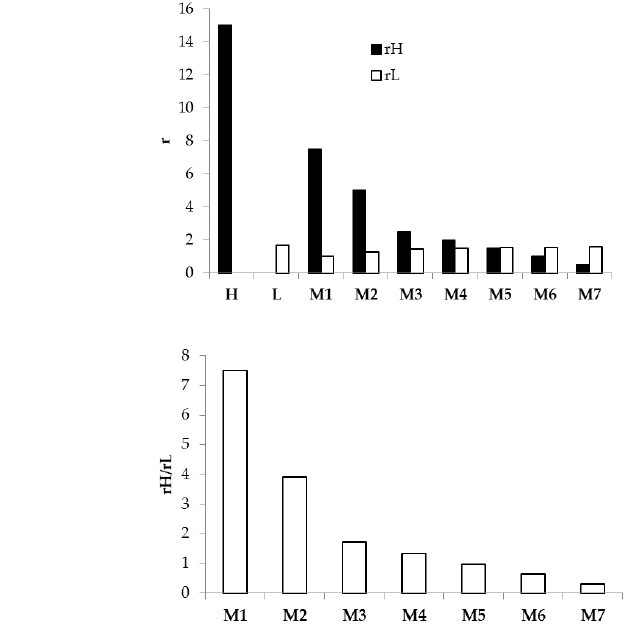
Figure 7. ( a ) rH and rL values calculated for H, L, and Ms; ( b ) rH/rL ratio calculated for all Ms.